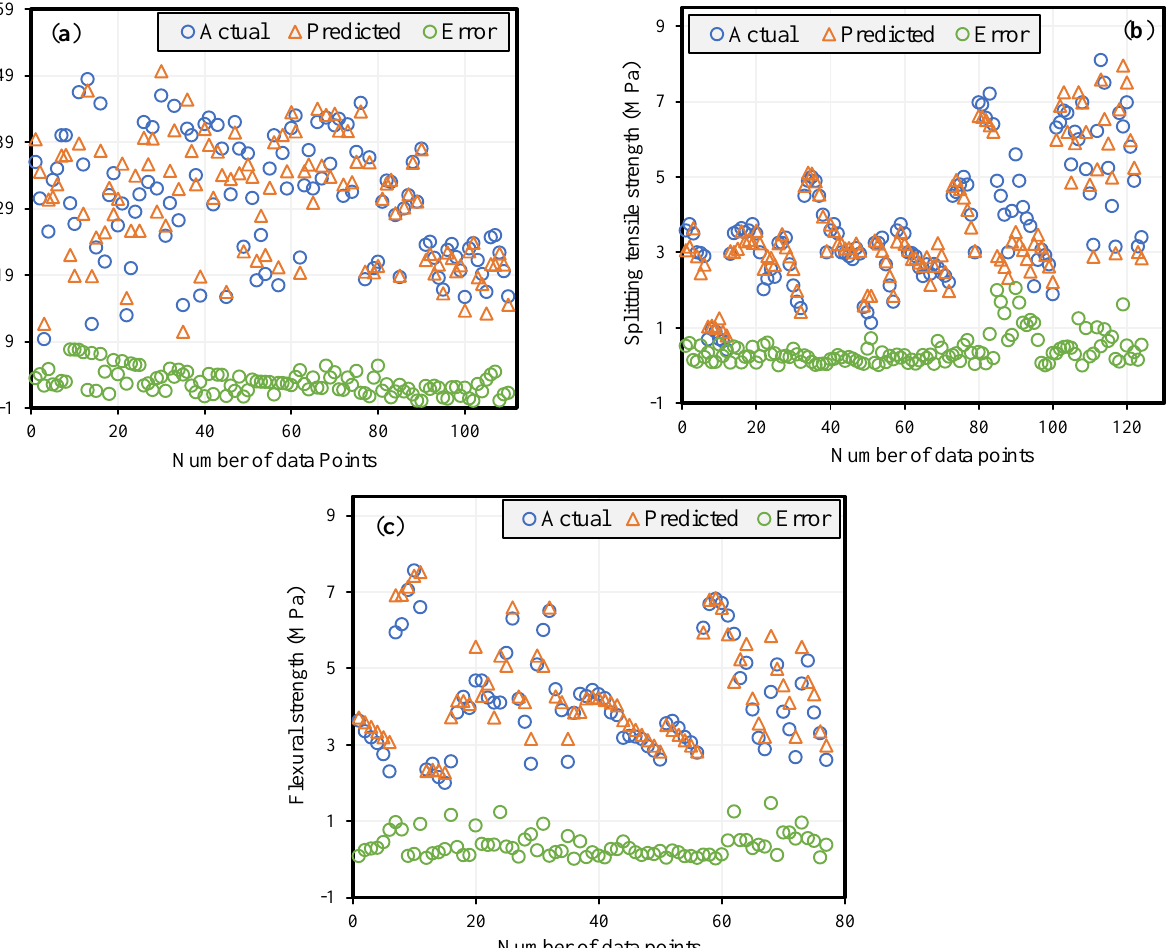
Figure 9. Deviation of the error between the actual and predicted results of MEP models developed for ( a ) f c ′ ( b ) f STS ( c ) f FS . Table 4. Inferential statistics for the training, testing, and validation datasets.